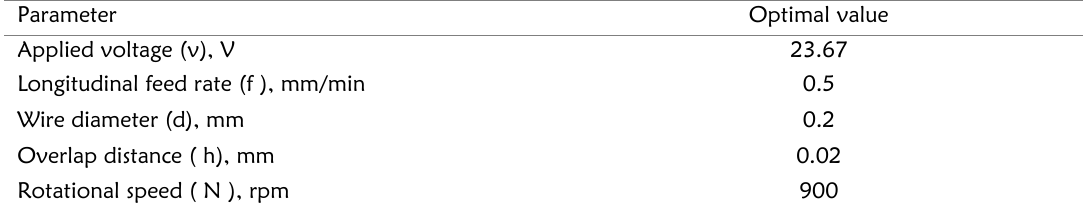
Table 5: Optimized input parameters in